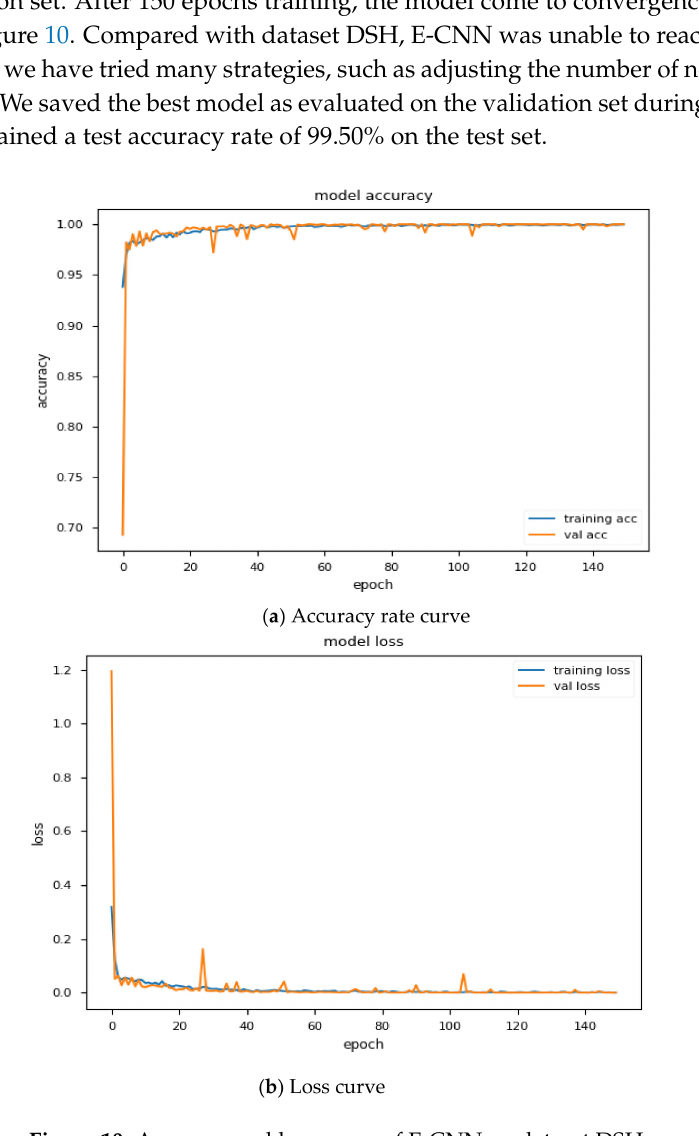
Figure 10. Accuracy and loss curve of E-CNN on dataset